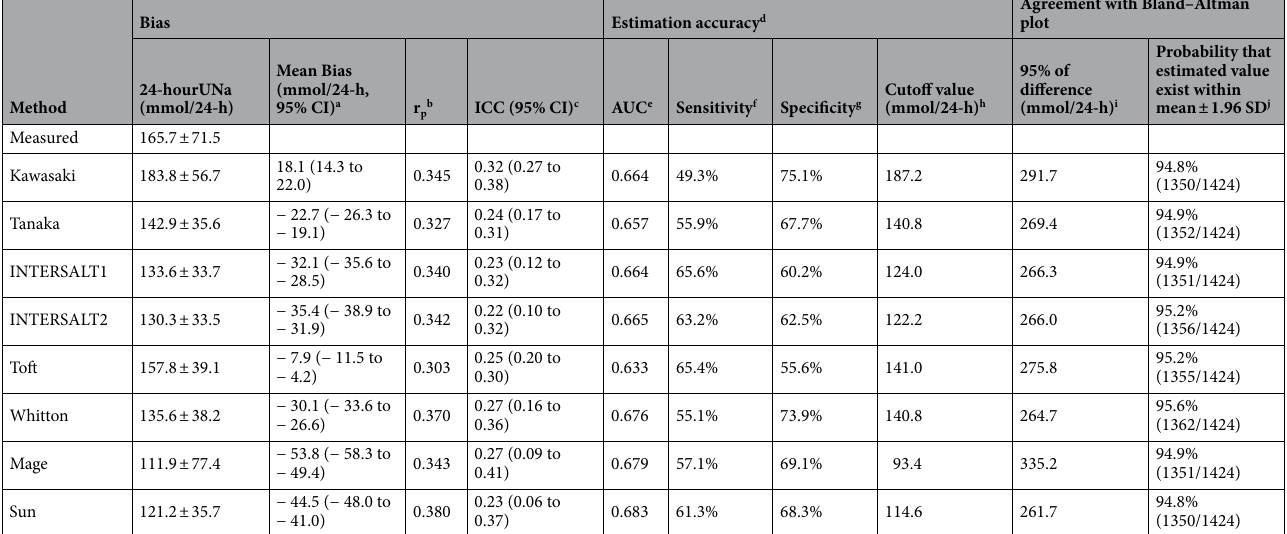
the Mage formula (335.2 mmol/24 h), followed by the Kawasaki formula (291.7 mmol/24 h). For all formulas, narrower limits of agreement facilitated the variability of the bias increase across increasing sodium levels; that is, the narrower the limit range was, the steeper the slope (the slope in the regression indicated the changes in bias per 1 mmol/24-h increase in the average estimated and measured 24-hUNa excretion). The regression showed that the trend of the bias was significant for each estimate by all formulas. The Mage and Kawasaki formulas presented a less extreme slope than the other formulas. Moreover, Bland–Altman plots further showed a nega- tive trend of mean biases across the level of sodium excretion, with the only exception being the Mage formula; in other words, compared with the average measured value, seven estimates were systematically biased with